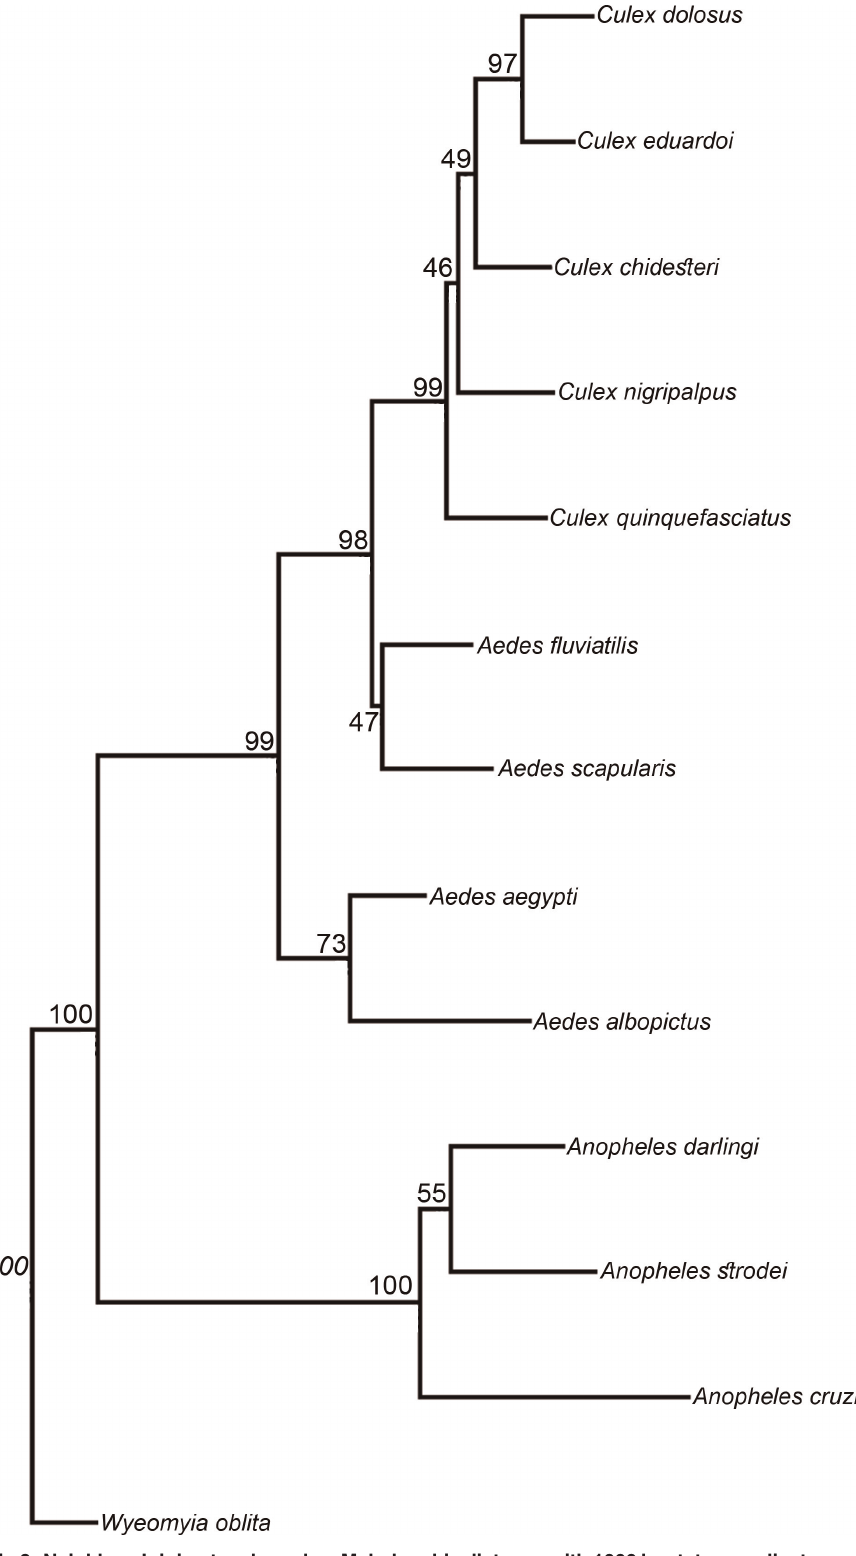
Fig 3. Neighbor-Joining tree based on Mahalanobis distance with 1000 bootstrap replicates.